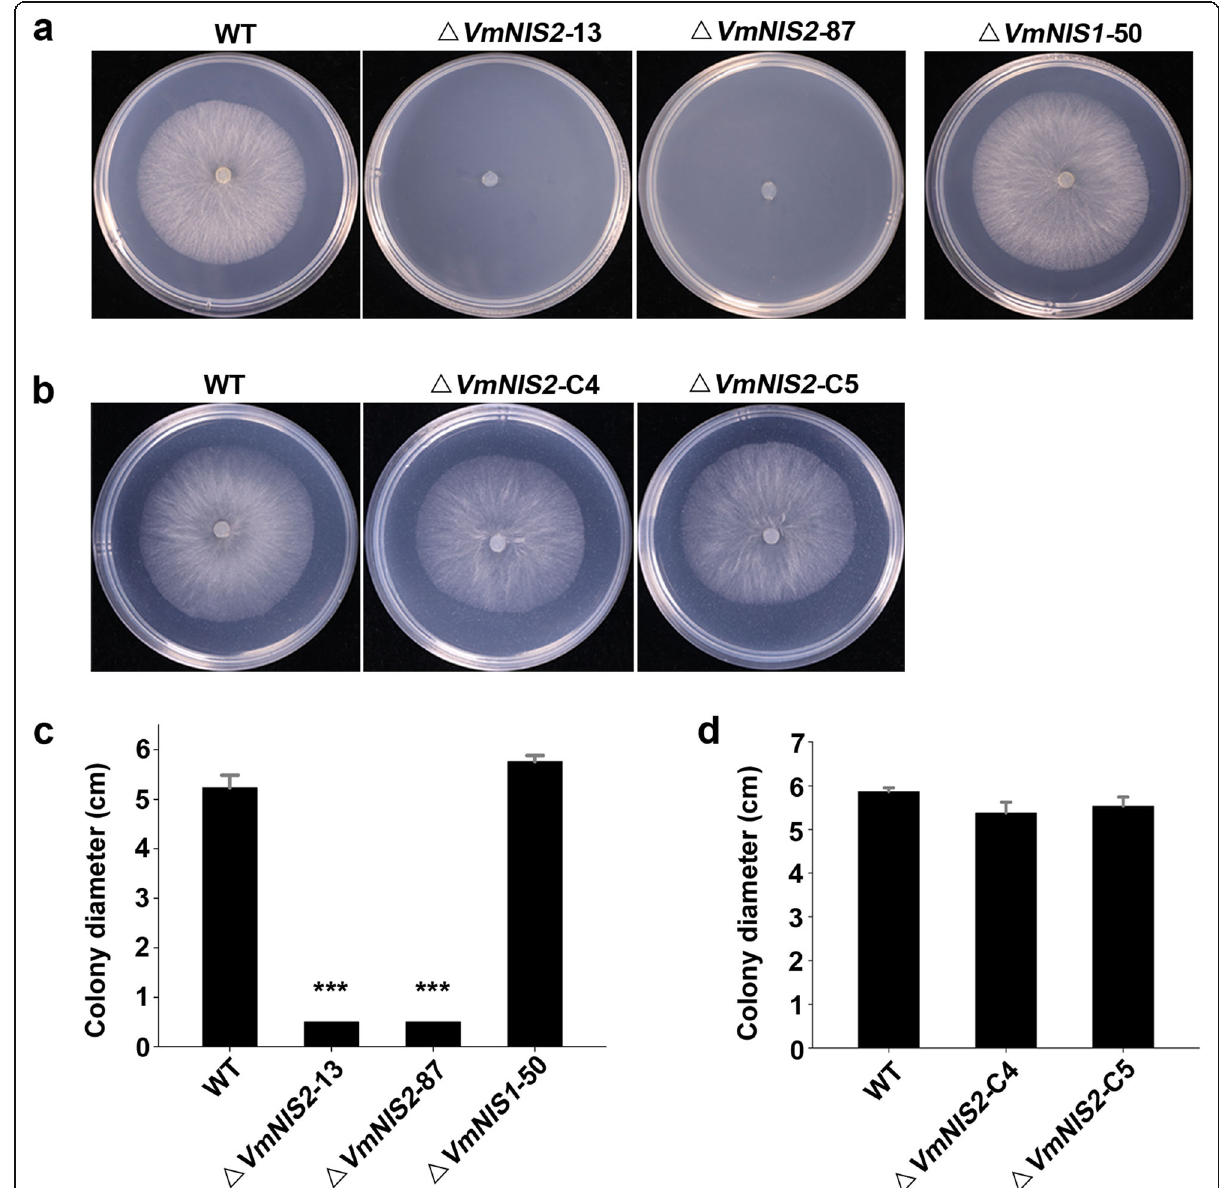
Fig. 6 VmNIS2 is required for V. mali tolerance to oxidative stress. a., c. Filamentous growth of V. mali wild type, VmNIS1 deletion mutant ( Δ VmNIS1 – 50), and VmNIS2 deletion mutants ( Δ VmNIS2 – 13 and Δ VmNIS2 – 87) on PDA medium supplemented with 10 mM H 2 O 2 . Representative photographs ( a ) were taken after culturing for 48 h. Colony diameters ( c ) were calculated from nine biological replicates. Values represent the means ± SD. Differences were assessed by Student ’ s t -test. ***, P < 0.001. b., d. Filamentous growth of V. mali wild type and VmNIS2 complementation transformants ( Δ VmNIS2 -C4 and Δ VmNIS2 -C5) on PDA medium supplemented with 10 mM H 2 O 2 . Representative photographs ( b ) were taken after culturing for 48 h and colony diameters ( d ) were calculated. Values represent the means ± SD from nine biological